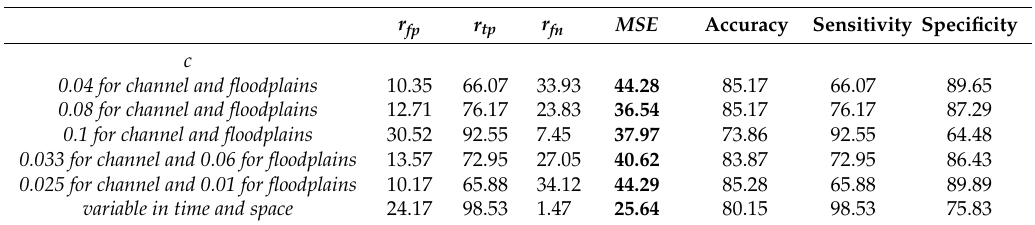
Table 6. Results of hydraulic simulation model calibration performance for 2 December 2013 in terms of a flood extent map: the set of Manning coefficients c , false positive rate r fp , true positive rate r tp , negative rate r fn , minimized sum of errors ( MSE ), and accuracy, sensitivity, and specificity.